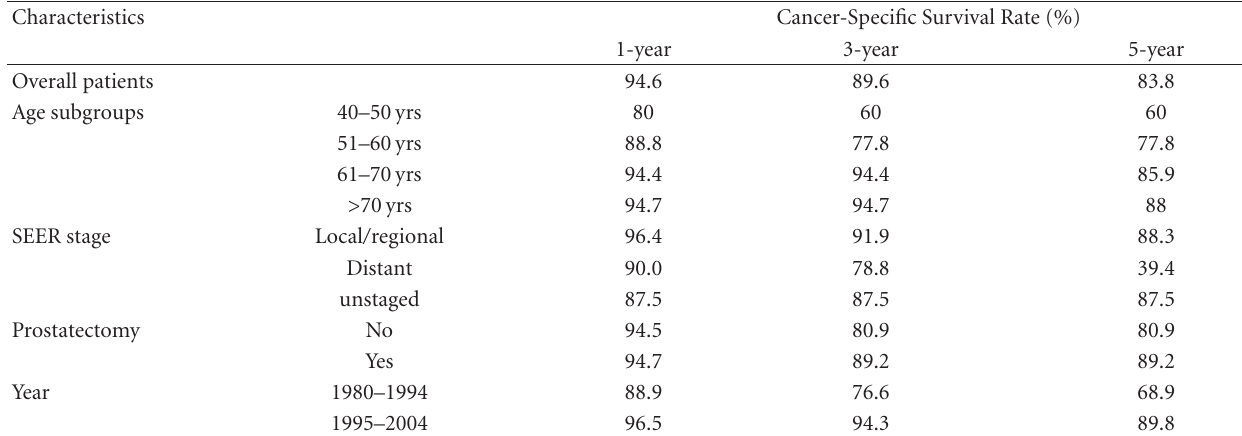
Table 5: 1-, 3-, and 5-year cancer-specific Survival of Patients with Signet Ring Prostate Carcinoma According to Demographic and Clinical